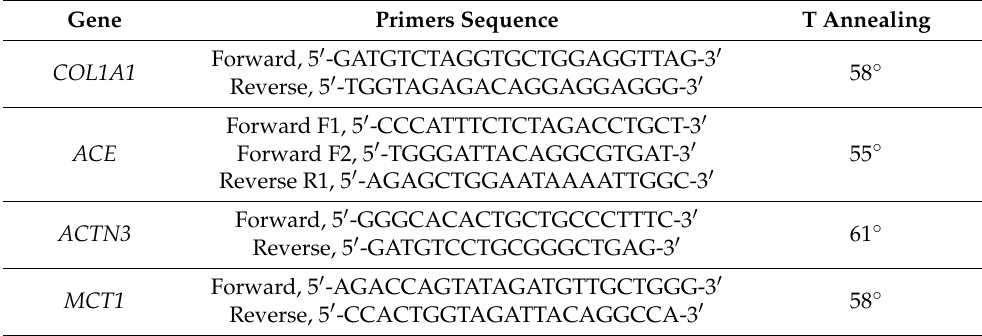
Table 1. Sequence of primers used for the DNA analysis.